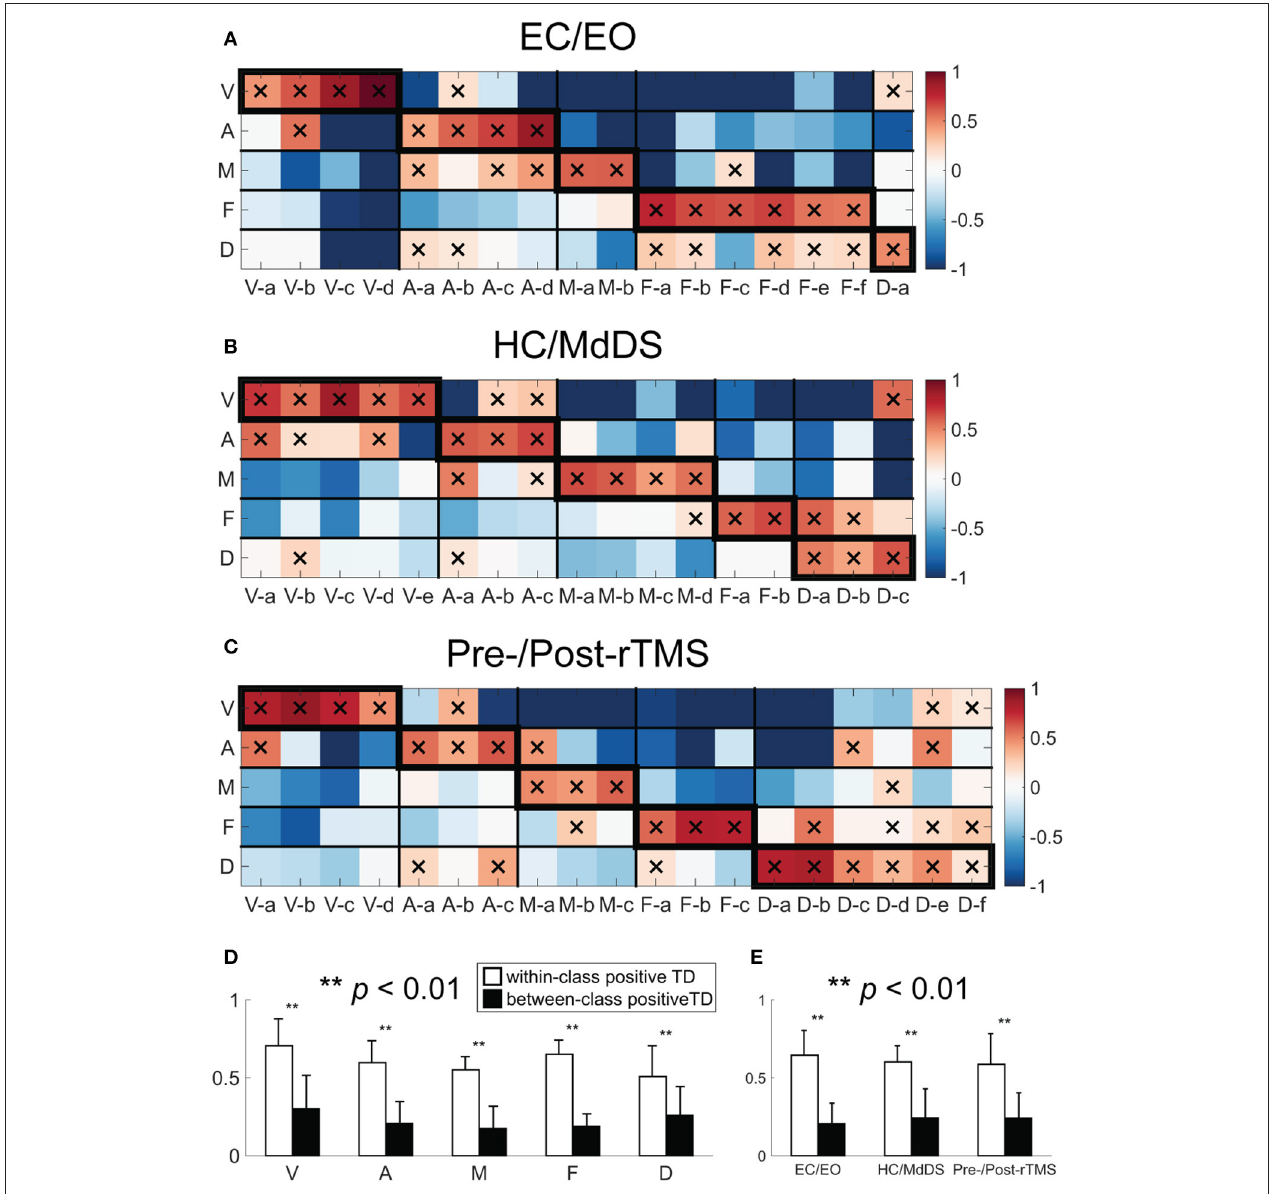
FIGURE 5 | Template-matching degree (TD) between TFICA-SCT derived-RSNs and fMRI RSN templates in (A) EC/EO; (B) HC/MdDS; (C) Pre-/Post-rTMS. (D) Bar-plots of the within-class (enclosed with thicker boundaries) and between-class positive TDs over five RSN classes; (E) Bar-plots of the within-class and between-class positive TDs over three datasets. Note that only positive TD values were considered since negative values indicate